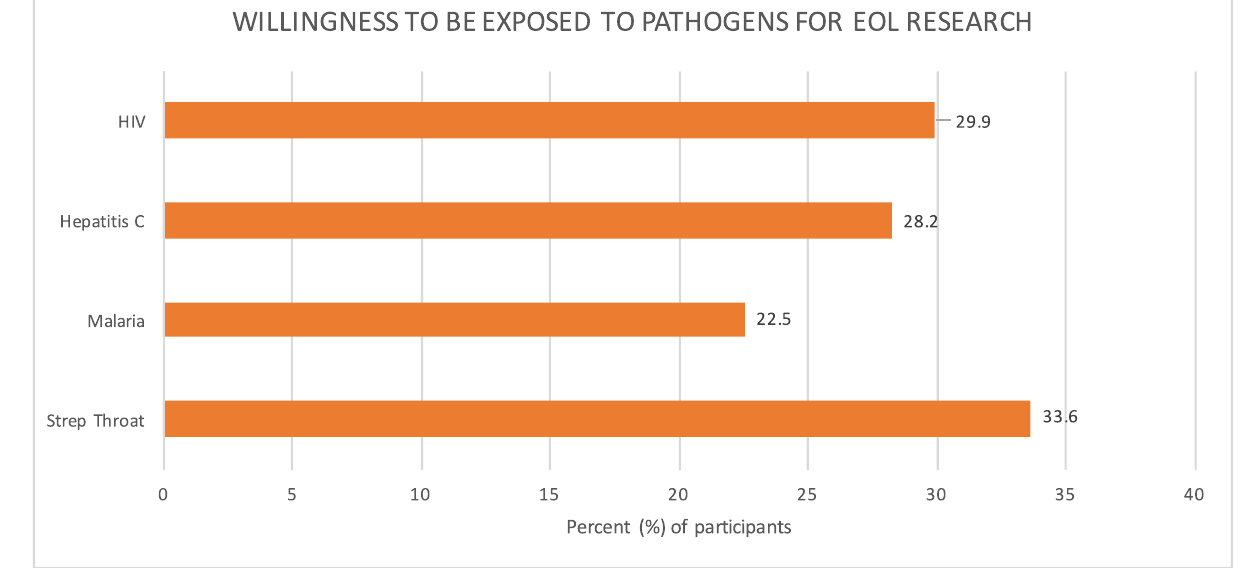
Fig 2. Willingness to be exposed to infectious pathogens for end of life research. Our surveys found that around one-third of the HIV-negative group was willing to be exposed to and infected by an infectious pathogen for the sake of research. Participants were most willing to be exposed to streptococcus (33.6%. n = 118) infections, followed by HIV (29.9%, n = 105).